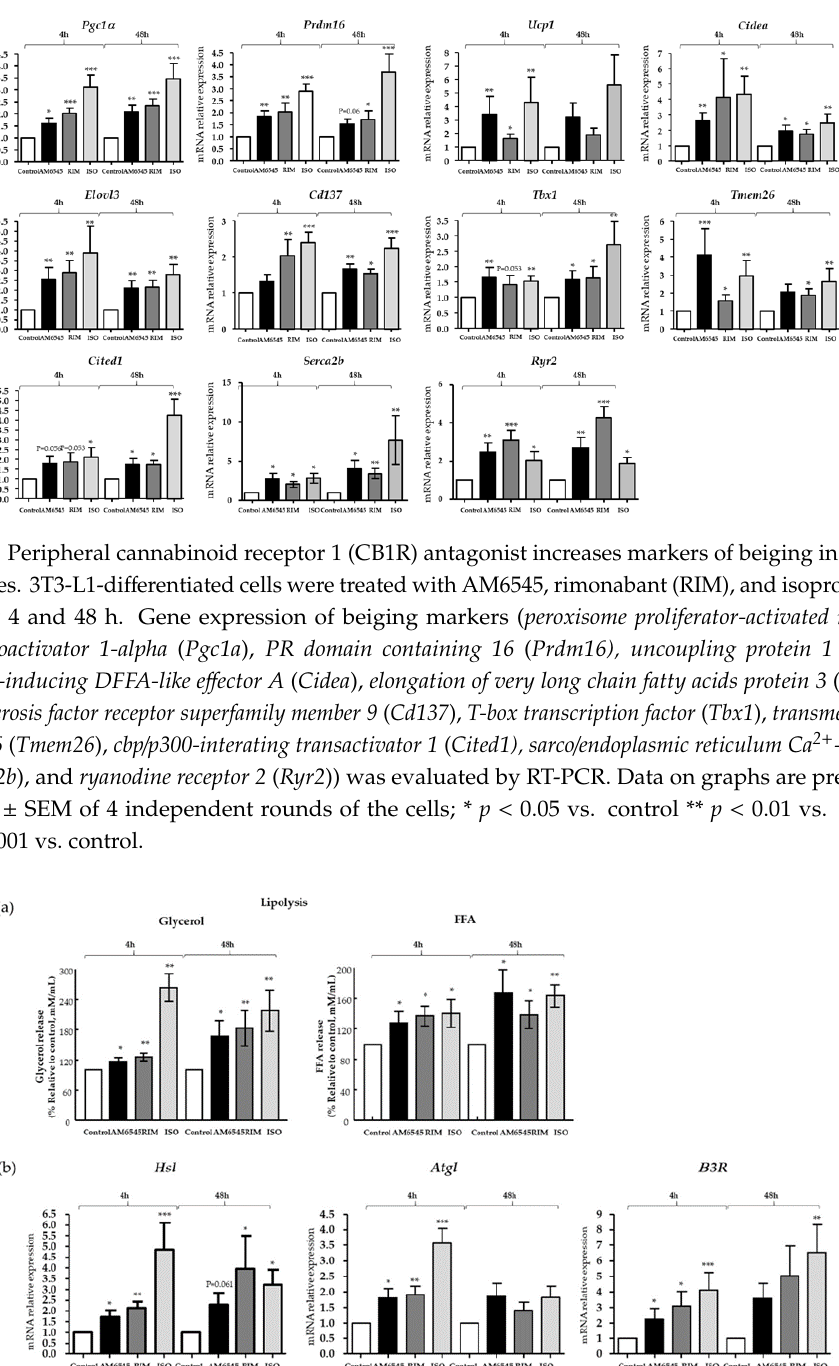
* p < 0.05 vs. control ** p < 0.01 vs. control *** p < 0.001 vs.